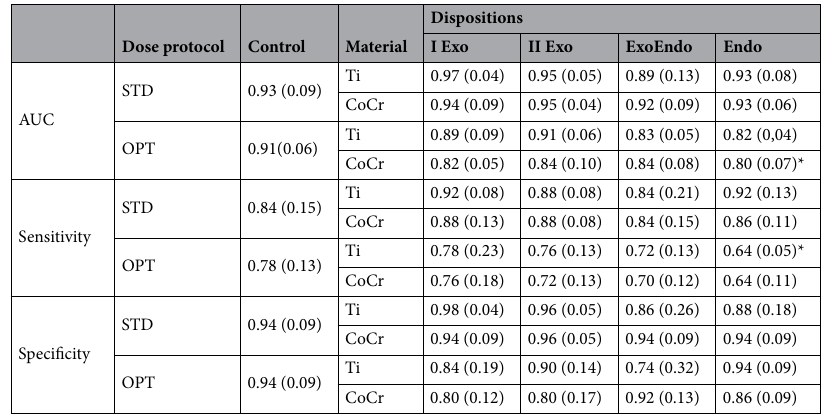
Table 1. Mean values (standard deviation) of the area under the receiver operating characteristics curve (AUC), sensitivity, and specificity for different dose protocols, material dispositions and compositions. Asterisk indicates significantly lower sensitivity than the standard protocol for the same material and